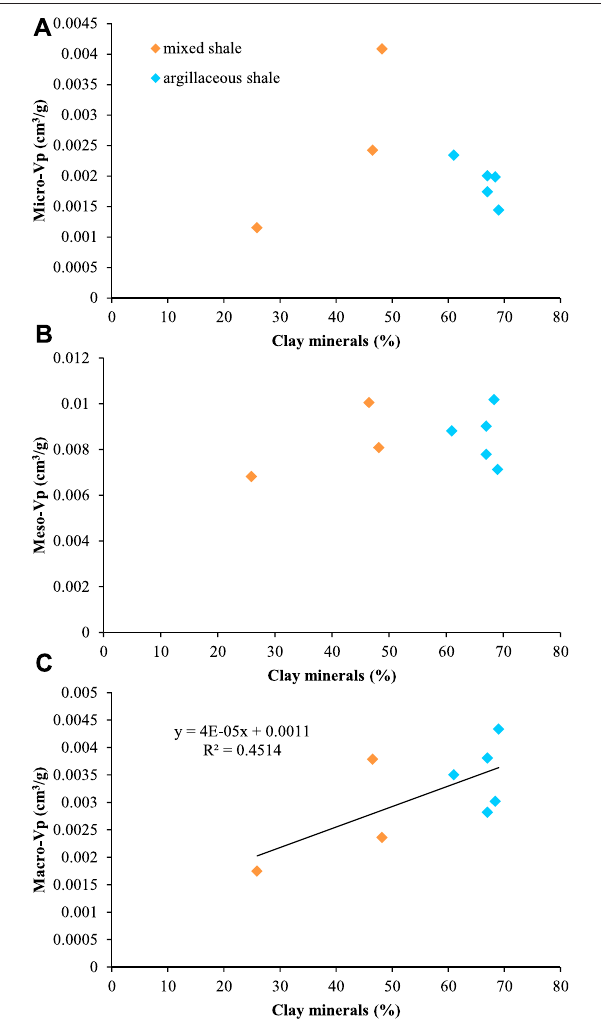
FIGURE 10 | Intersection diagrams of clay minerals and pore structure parameters. (A) clay minerals and micro-V p ; (B) clay minerals and meso-V p ; (C) clay minerals and macro-V p .